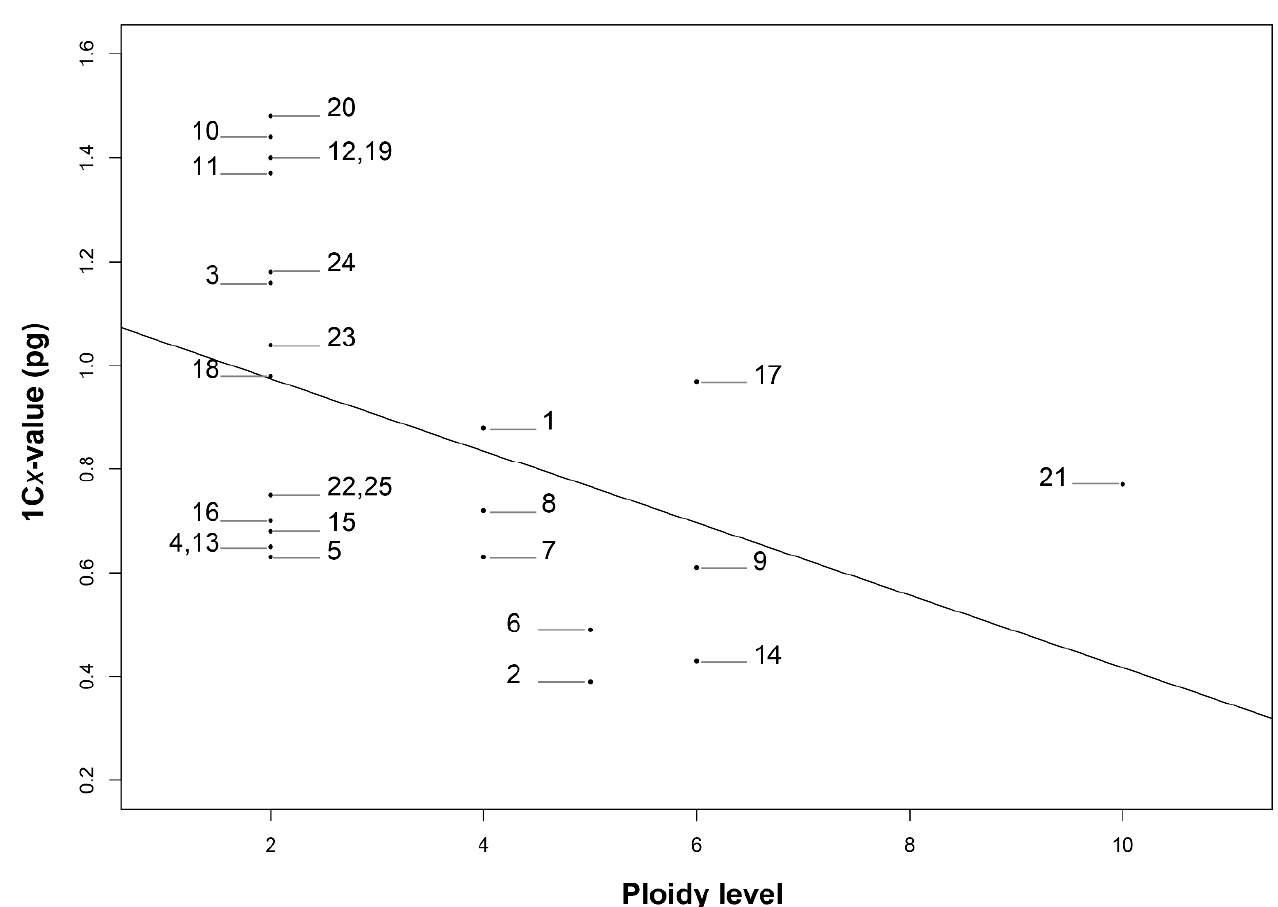
Figure 8. Correlation between the DNA 1C x -value and ploidy level in 23 species of Echeveria . (1) E. altamirae, 1C x = 0.88 pg. (2) E. caamanoi, 1C x = 0.39 pg. (3) E. carnicolor, 1C x = 1.16 pg. (4) E. catorce, 1C x = 0.65 pg. (5) E. catorce, 1C x = 0.63 pg. (6) E. cuicatecana, 1C x = 0.49 pg. (7) E. cupreata, 1C x = 0.63 pg. (8) E. dactylifera , 1C x = 0.72 pg. (9) E. gibbiflora, 1C x = 0.61 pg. (10) E. guerrerensis, 1C x = 1.44 pg. (11) E. guerrerensis , 1C x = 1.37 pg. (12) E. helmutiana, 1C x = 1.40 pg. (13) E. juarezensis, 1C x = 0.65 pg. (14) E. longiflora, 1C x = 0.43 pg. (15) E. magnifica, 1C x = 0.68 pg. (16) E. multicaulis, 1C x = 0.70 pg. (17) E. novogaliciana, 1C x = 0.97 pg. (18) E. olivacea, 1C x = 0.98 pg. (19) E. pallida, 1C x = 1.40 pg. (20) E. perezcalixii, 1C x = 1.48 pg. (21) E. roseiflora, 1C x = 0.77 pg. (22) E. schaffneri, 1C x = 0.75 pg. (23) E. triquiana, 1C x = 1.04 pg. (24) E. uhlii, 1C x = 1.18 pg. (25) E. zorzaniana, 1C x = 0.75 pg. Correlation results were statistically significant ( p < 0.03 with r = −